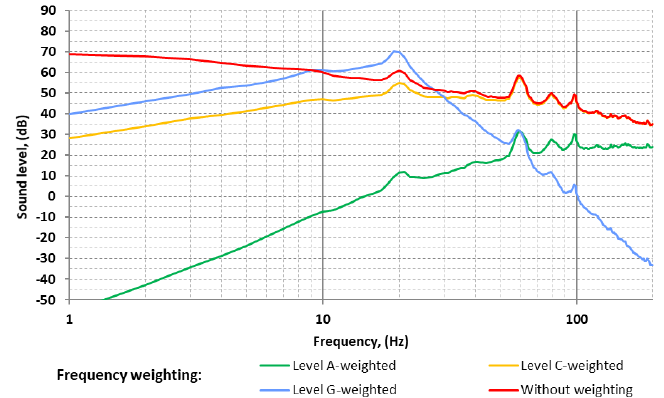
Figure 7. Courses of noise spectra generated by T4 turbine by application of various weighting curves.